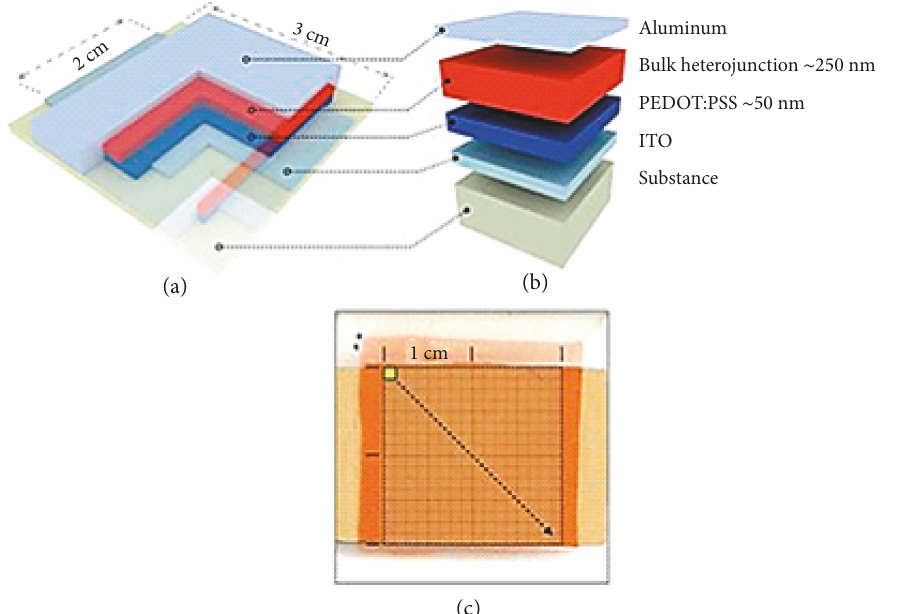
Figure 1: (a) Device layout overview and dimensions. (b) Sequentially deposited layers. (c) Example of the fi nal device and active area mapping increase from the initial dimension (0.1 × 0.1cm 2 ) to the maximum available active area (2 × 2cm 2